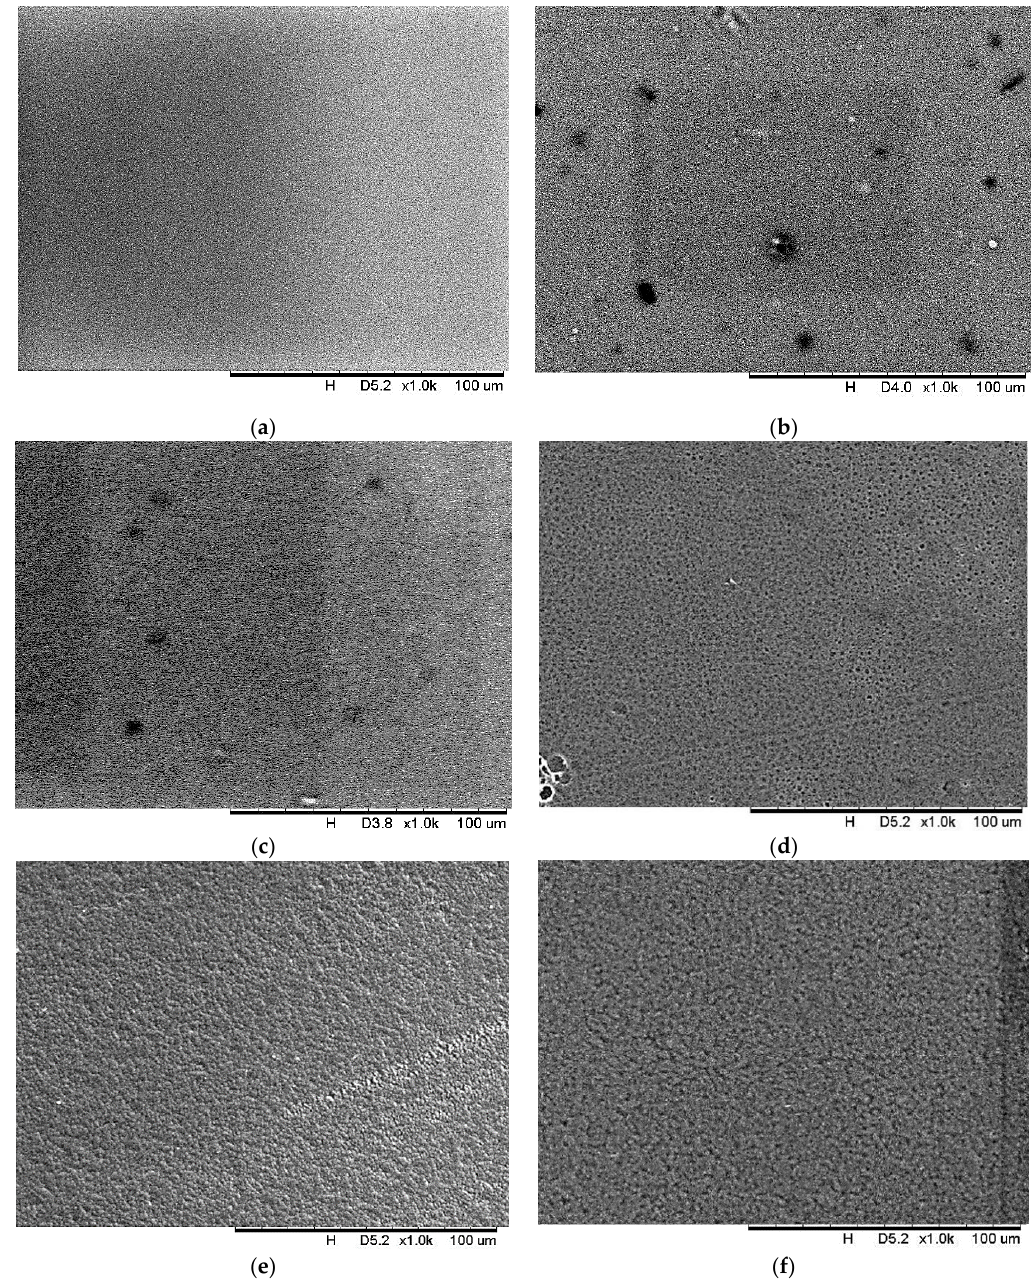
Figure 10. SEM image at 1000× of ( a ) M1, ( b ) M2, ( c ) M3, ( d ) M4, ( e ) M5 and ( f ) M6.